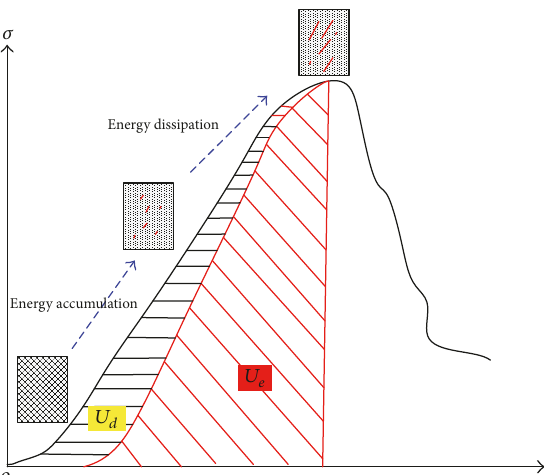
Figure 13: Relationship between dissipation strain energy 𝑈 𝑑 and release elastic strain energy 𝑈 𝑒 in the stress-strain